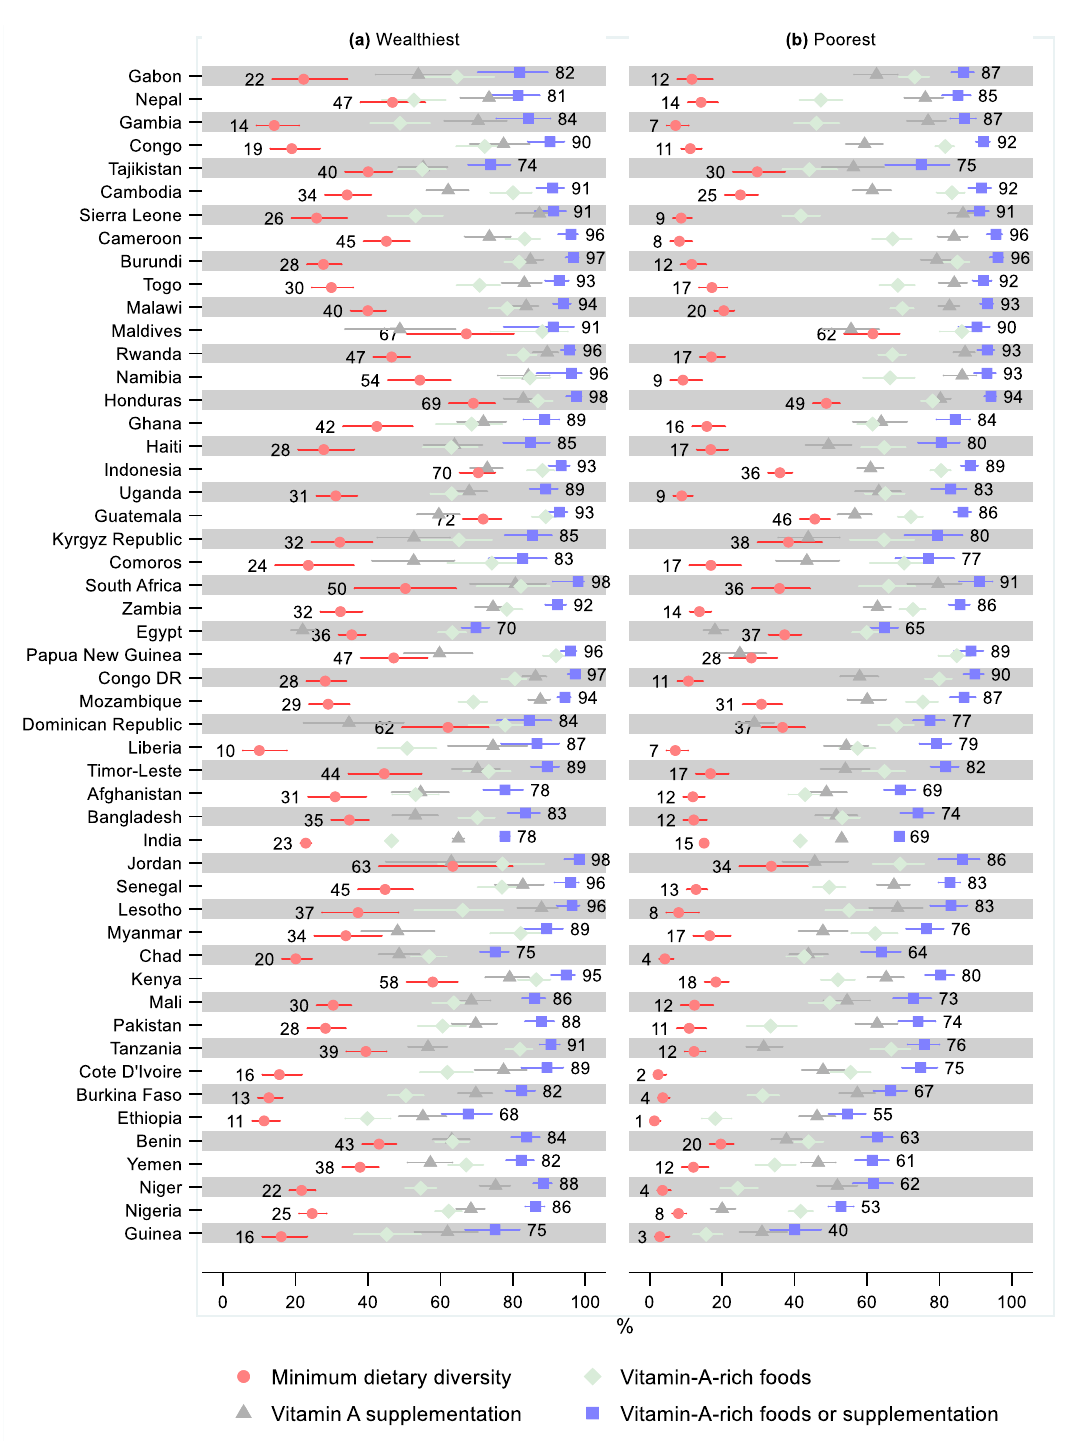
Figure 6. Percentage of children 6–23 months old that received minimum dietary diversity, vitamin- A-rich foods, vitamin A supplementation, and either vitamin-A-rich foods or vitamin A supplementation by living standards and country. Notes: 95% confidence intervals are shown. Countries are ordered from largest to smallest relative living standards difference in percentage of children that received either vitamin-A-rich foods or supplementation. Some confidence intervals may be narrower than the symbol for the estimate and therefore not visible. See Tables S9–S12 in the Supplement for the tabulated estimates and confidence intervals. See Figures S13–S16 in the Supplement for the plotted relative differences.